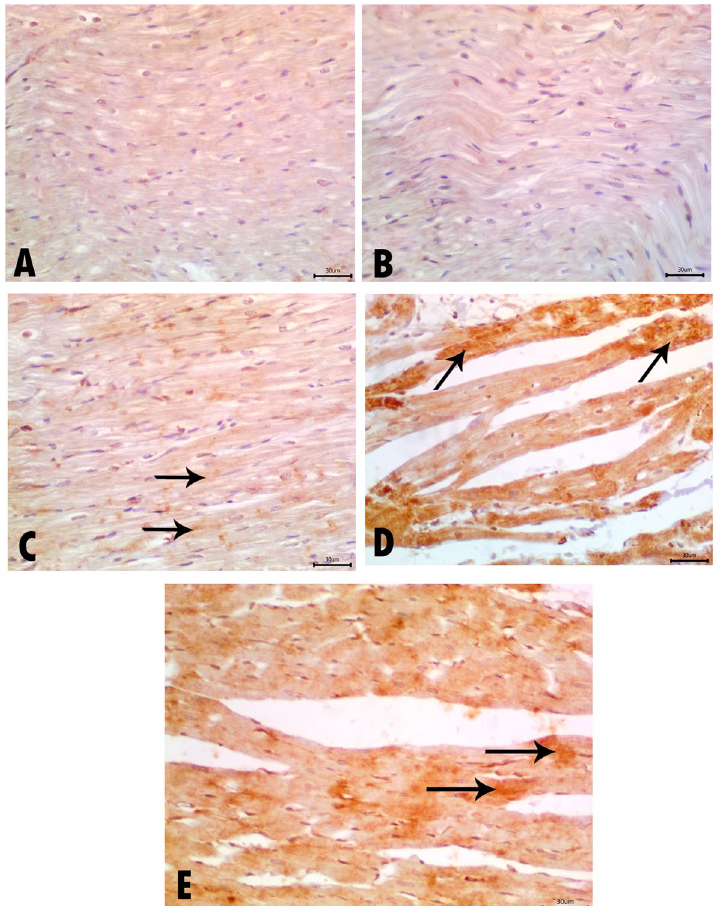
Fig. 14 Photomicrographs of sections in the heart immunohistochemically stained with caspase-3 ( groups show negative expression of caspase-3 in cardiomyocytes. C The acute treated group shows weak positive Caspase-3 expression in cardiomyocytes (arrows). D Chronic treated group reveals strong Caspase-3 expression in cardiomyocytes (arrows). E Chronic withdrawal group shows caspase-3-positive expression in cardiomyocytes